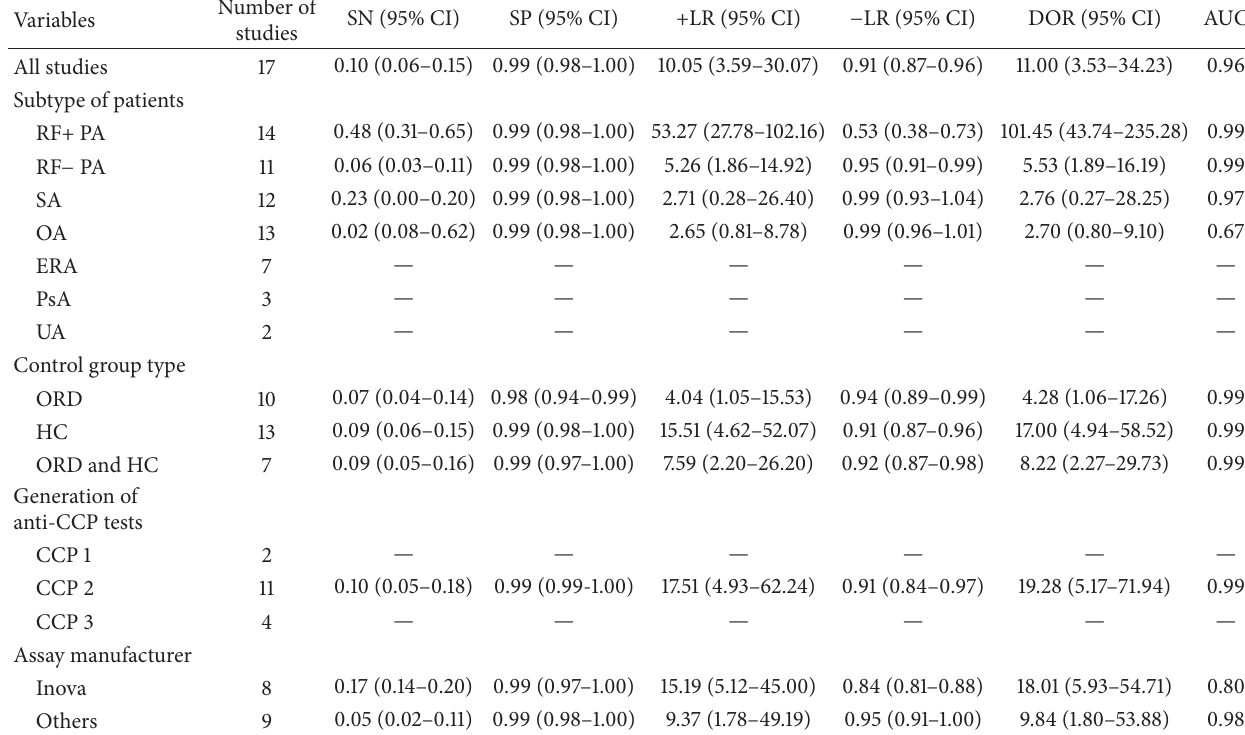
Table 2: Summary of subgroup analysis of the included studies by different study